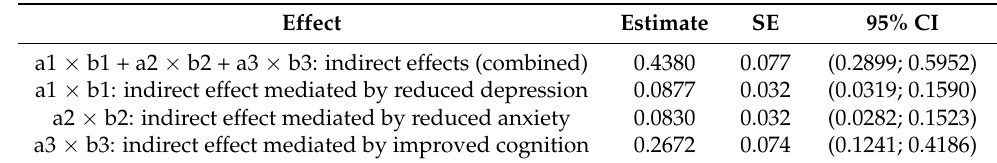
Table 3. Estimation of indirect effects using the bootstrap method—model with three mediators based on pooled data from three trials (subset of patients with tinnitus at baseline, full analysis set); parameter estimate, standard error (SE) and 95% confidence interval